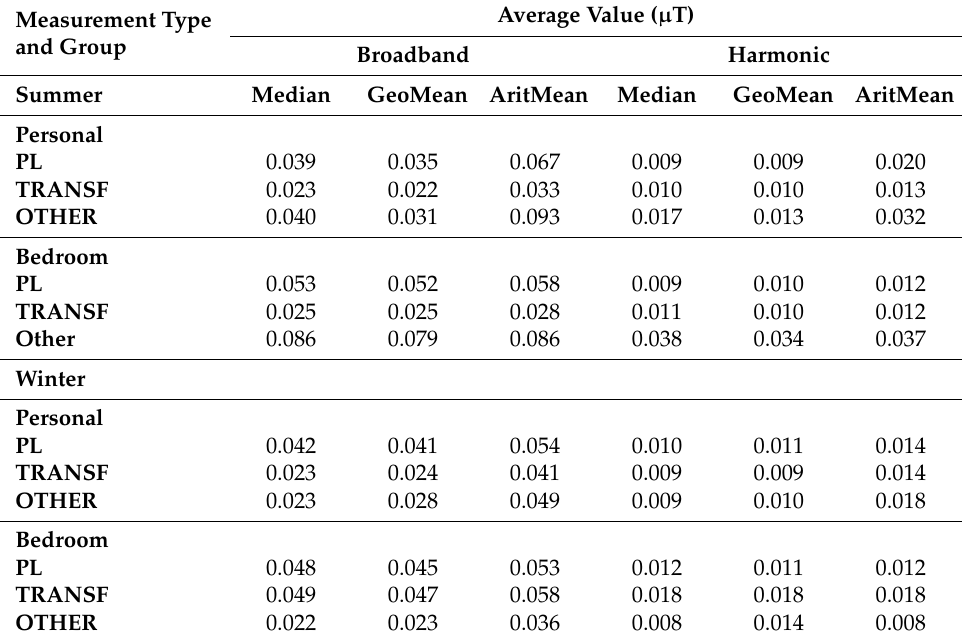
Figure 4. Distribution of the median, geometric mean, and arithmetic mean of magnetic field ( μ T) in the harmonic frequency range (100–800 Hz) indicated as box-plots for bedroom measurements in both summer and winter periods and in each group. The distribution values are indicated in Appendix Table A4. Table 3. Average value of the median, geometric mean, and arithmetic mean of magnetic field in each group for personal and bedroom measurements in each season for both broadband and harmonic frequency